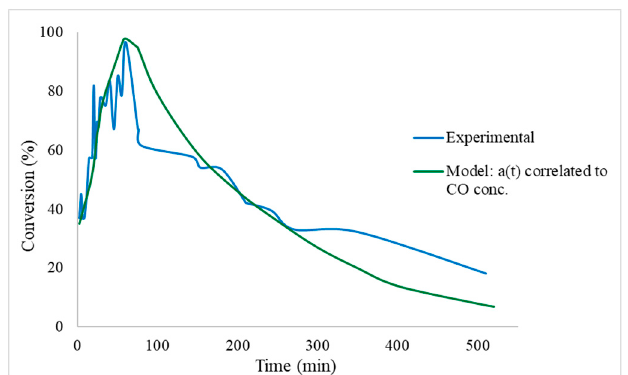
Figure 3. Conversion of formic acid against time with catalytic activity correlated to CO concentration in microreactor. Reaction conditions: temperature = 30 °C; pressure = 1 bar; inlet flow = 0.05 mL/min; 0.1 g catalyst of 5 wt.% Pd on Carbon.